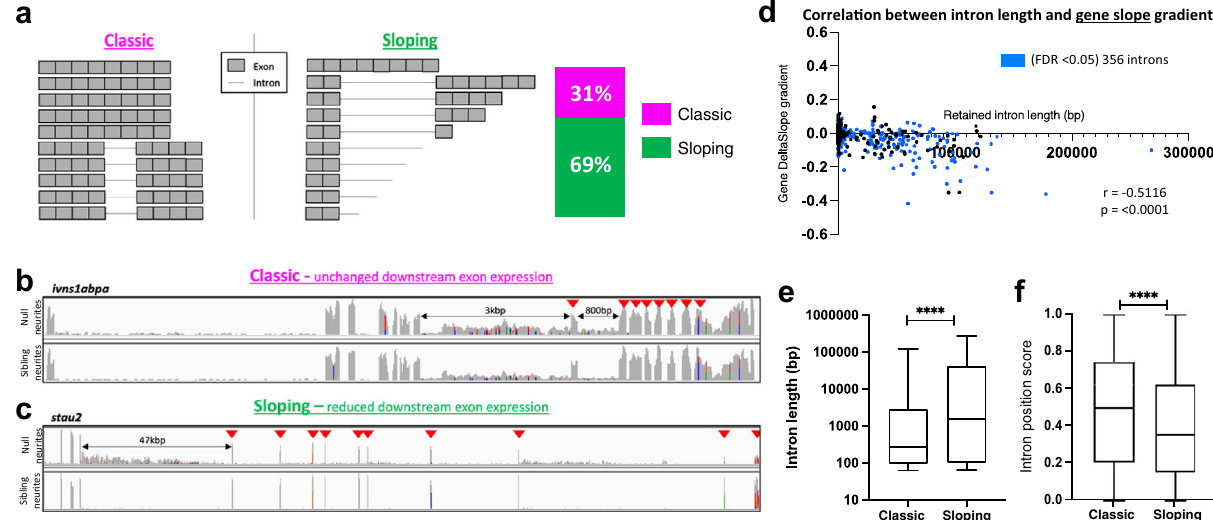
Fig. 3 | Two types of intron-retaining transcripts become neurite localised in null neurons. a Schematic representation of the two types of IR-transcripts enri- ched in null neurites. The stacked bar graph shows the proportion of genes expressing ‘ classic ’ full-length IR transcripts (magenta) and ‘ sloping ’ prematurely terminated IR transcripts (green) transcripts; n =356 genes, FDR<0.05. b , c Example gene plots for each of the two types of IR-transcript in null neurites. Arrows indicate exons downstream of the retained intron/s. b ivns1abpa , intron-8- retaining, and intron-9-retaining transcripts with no change in downstream exons expression. c stau2 , intron-5-retaining transcripts showing reduced expression of downstream exons. d Correlation between retained intron length and 5 ’ → 3 ’ exonic readslopegradient.Gradientscalculatedforthe356genesencodingIR-transcripts